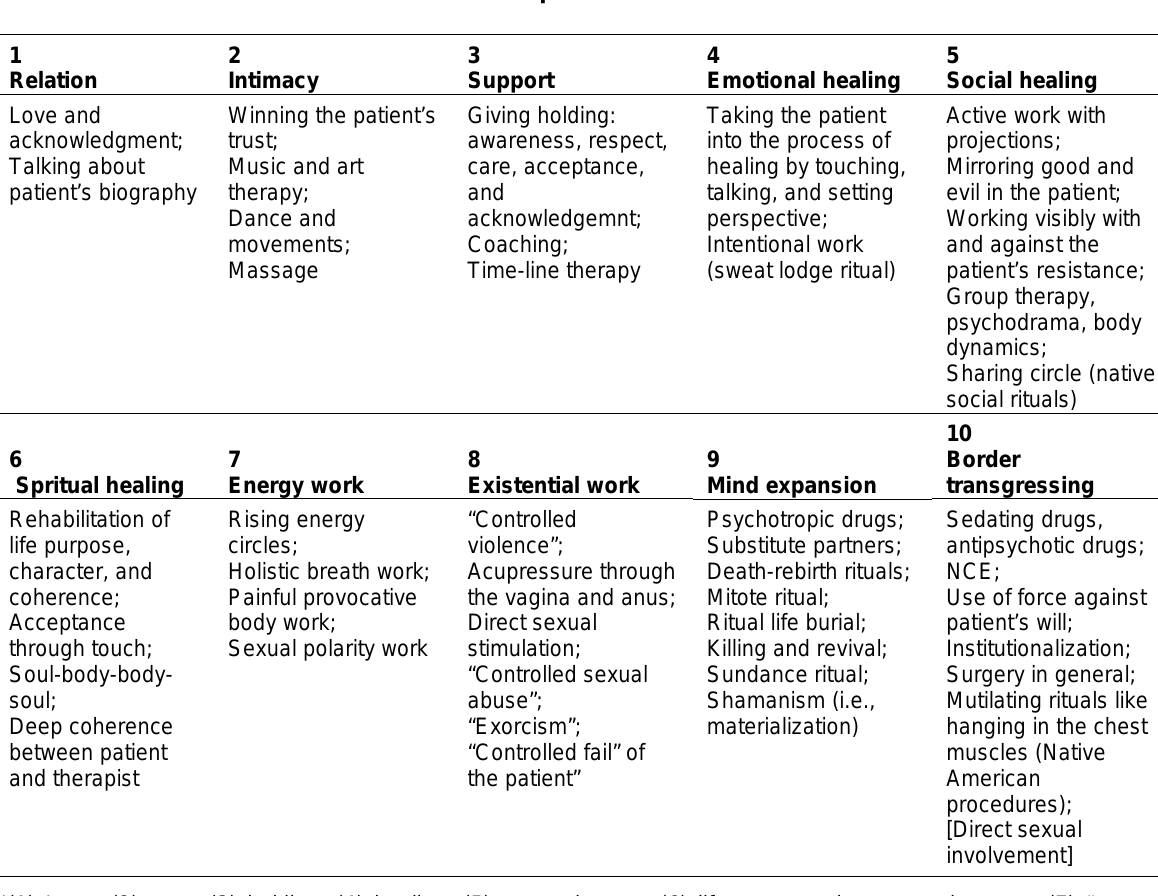
The Staircase of Increasingly Intense and Potentially Traumatic and Dangerous Holistic Medical Therapeutic